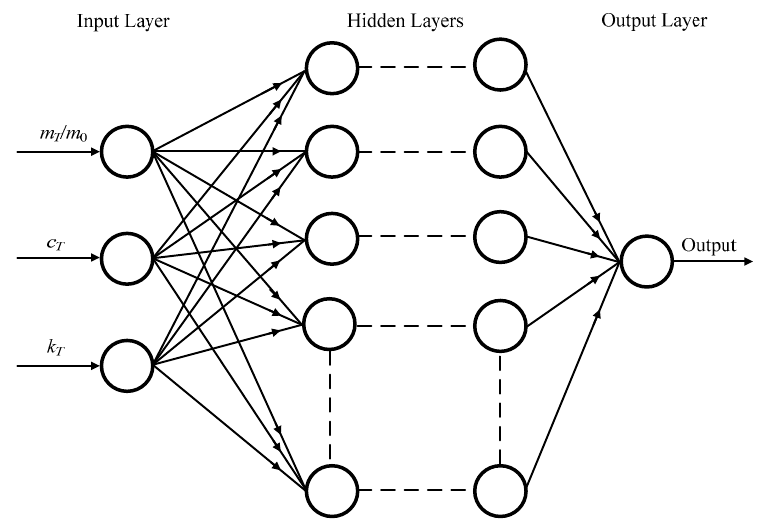
Figure 7. The ANN model with four inputs and one output.